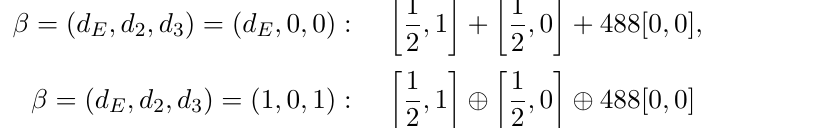
) = ( d 0 , 0) in E , d 2 , d 3 E ,